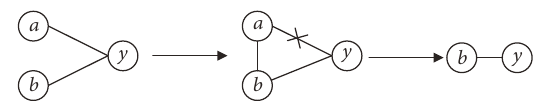
Figure 4: Disconnection of the neuron in the hidden layer and the neuron in output